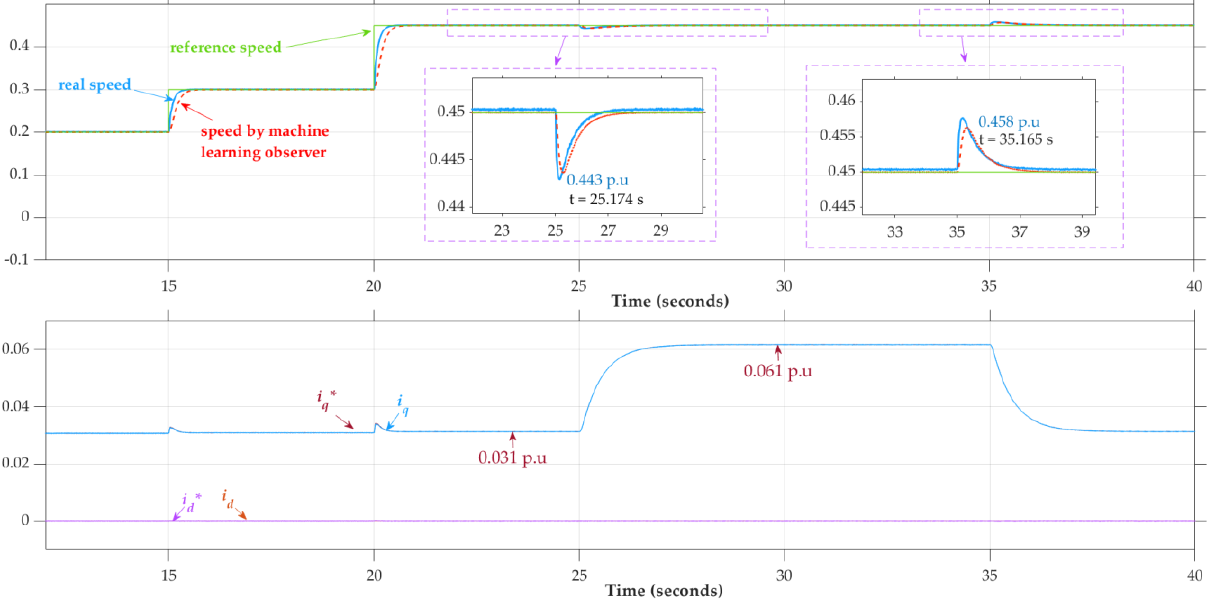
Figure 14. Speed and current simulation responses for external load variations (0.1 to 0.2 of rated torque) at 0.45 p.u-speed.